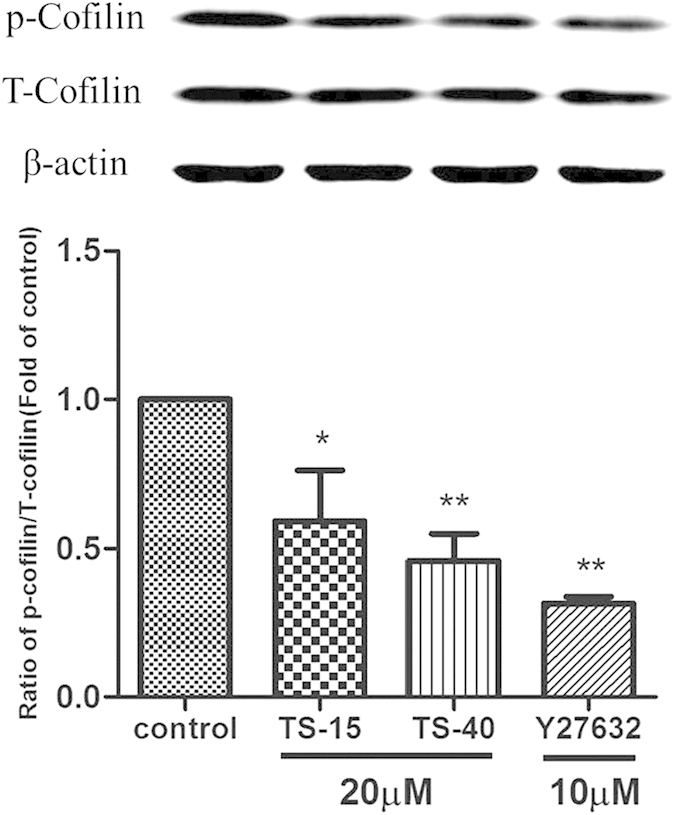
The down-regulations of TS-15 and TS-40 in the phosphorylations of cofilin in human umbilical vein endothelial cells.HUVEC was treated with Y27632, TS-15 or TS-40 for 2 hours. Then, the ratio of p-conflin to T-conflin of each group was normalized by the value the control. Data represented the mean ± RSD (n = 4). Statistical comparison of the data was performed by one-way ANOVA followed by Dunnett’s test. *P < 0.05 and **P < 0.01 compared to the control group.